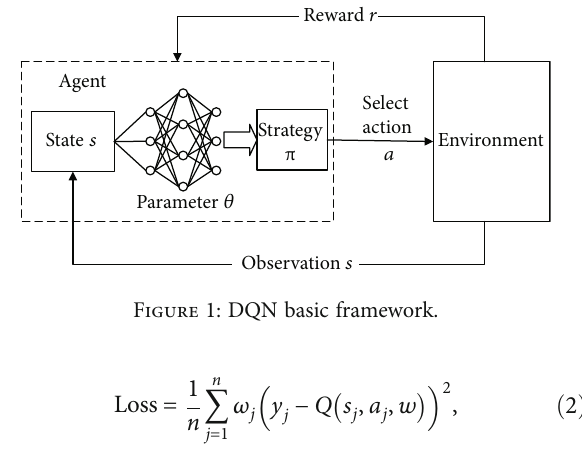
Figure 1: DQN basic